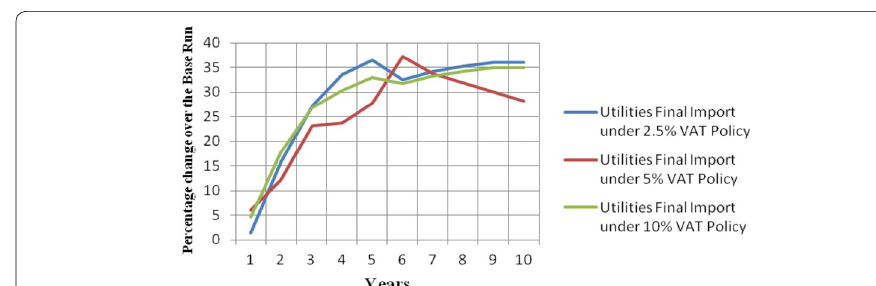
Fig. 37 Changes in utilities final imports under varying VAT rates